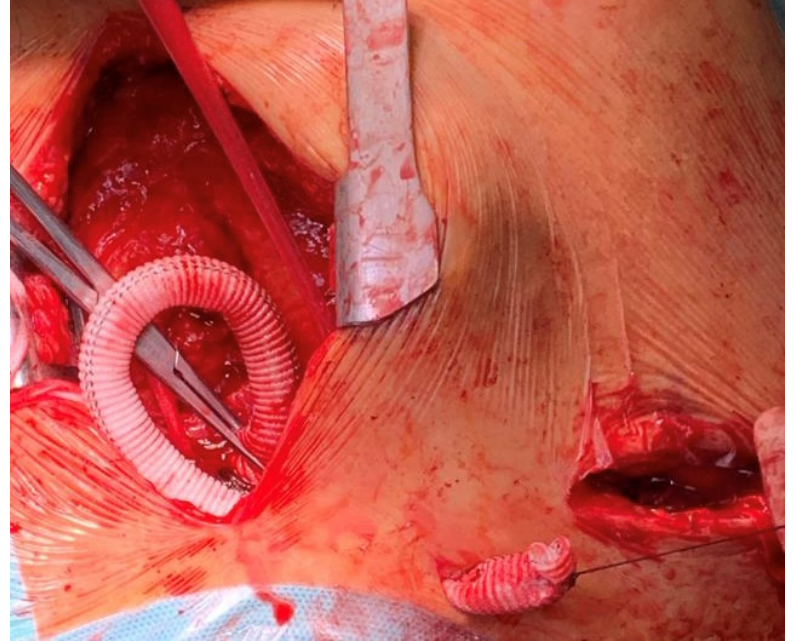
Figure 3. Tunneling of the graft via the subcutaneous supraclavicular space.